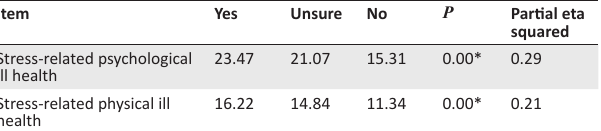
TABLE 8: ANOVA – Differences in stress-related ill health levels based on depression group.